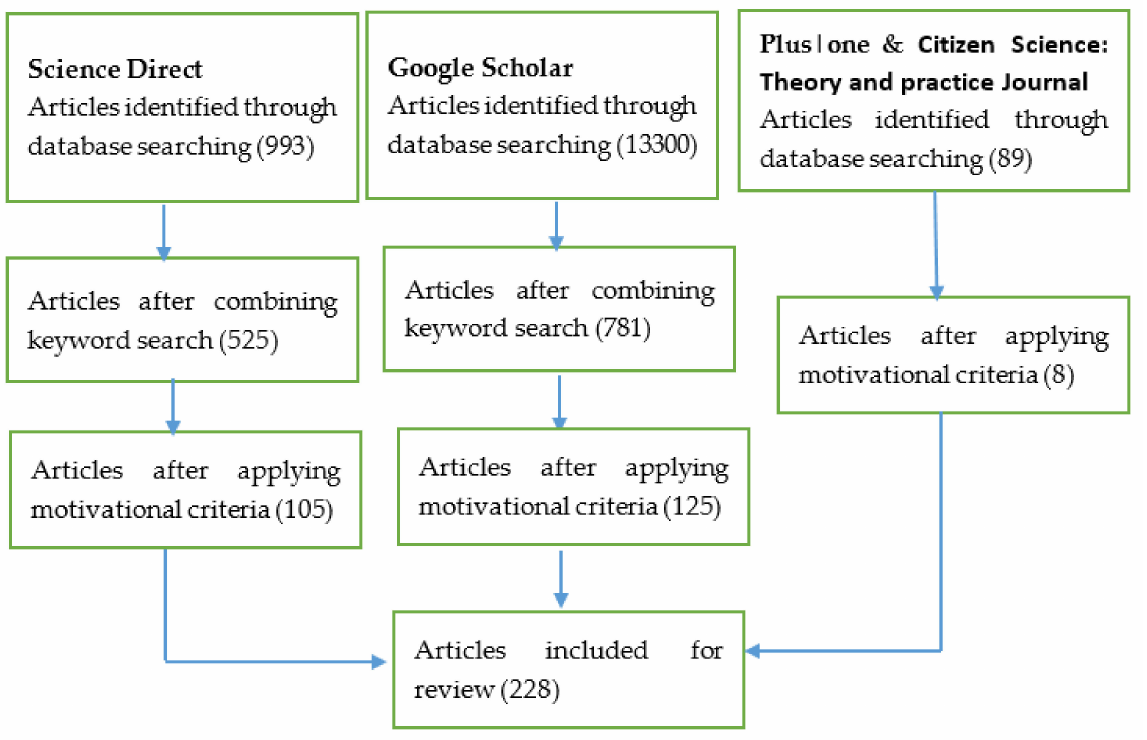
Figure 1. Stages of Systemic